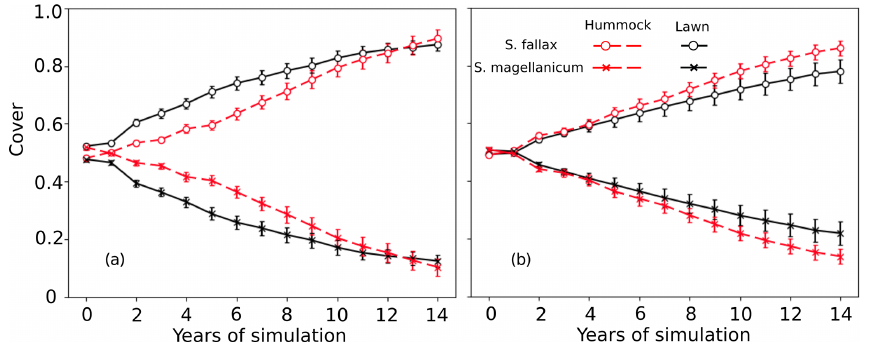
Figure 3. Testing the importance of capitulum water content for the habitat preference of S. magellanicum and S. fallax . The development of the relative cover (mean and standard error) were simulated in hummock and lawn habitats over a 15-year time frame for the two species. For both species, parameter values for the capitulum water content, the capitulum biomass ( B cap ), and the density ( D S ) were set to be the same as those from (a) S. magellanicum (Test 3) or (b) S. fallax (Test 4).